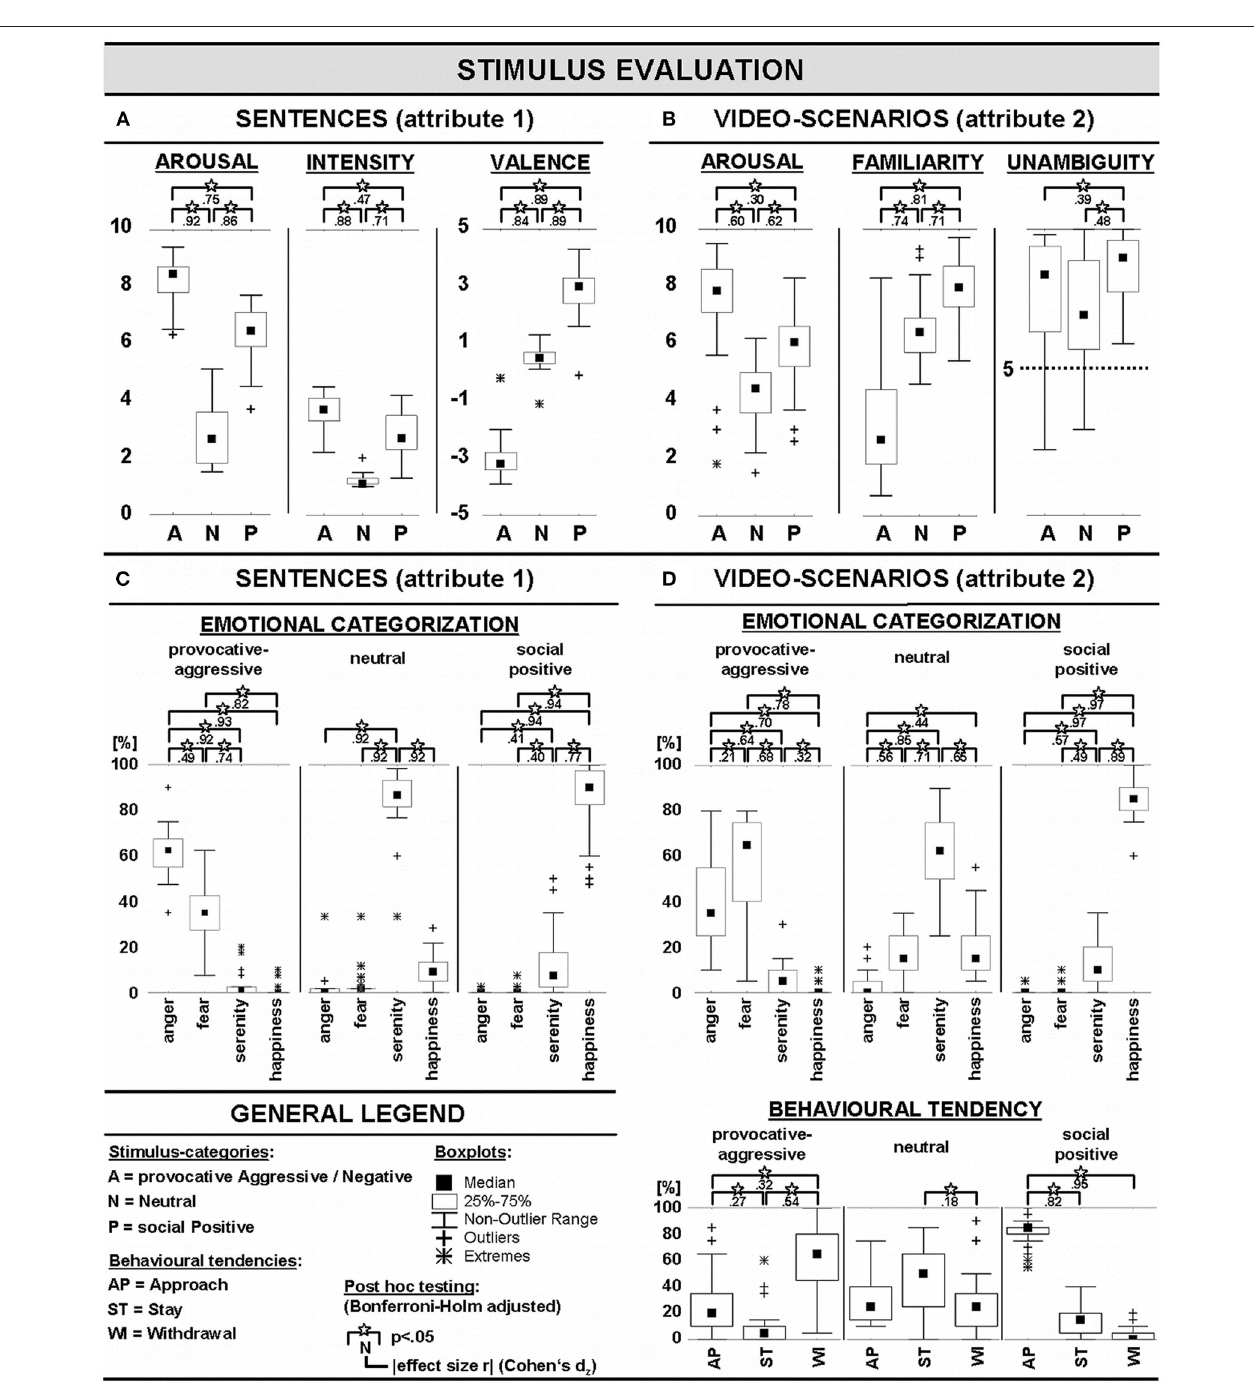
FIGURE 2 | Evaluation of sentence- and video-stimuli ( A,C : sentences, B,D : videos).